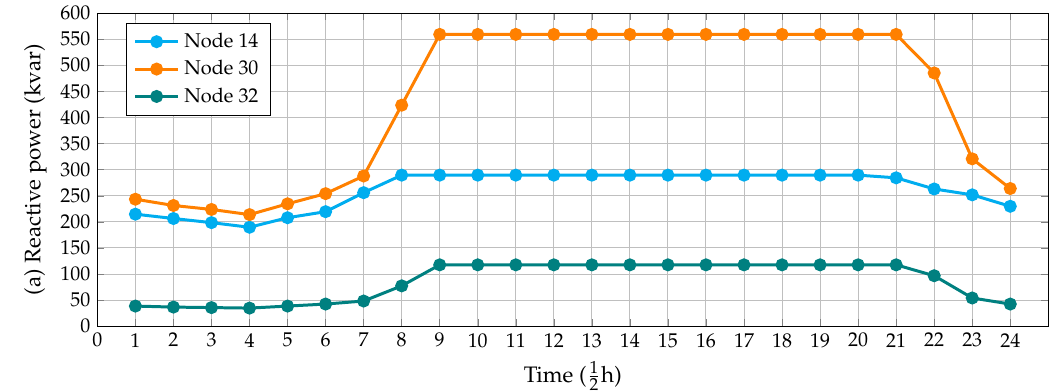
Figure 6. Dynamic reactive power behavior during a typical operation day for the D-STATCOMs in electric distribution networks in the IEEE 33-bus test